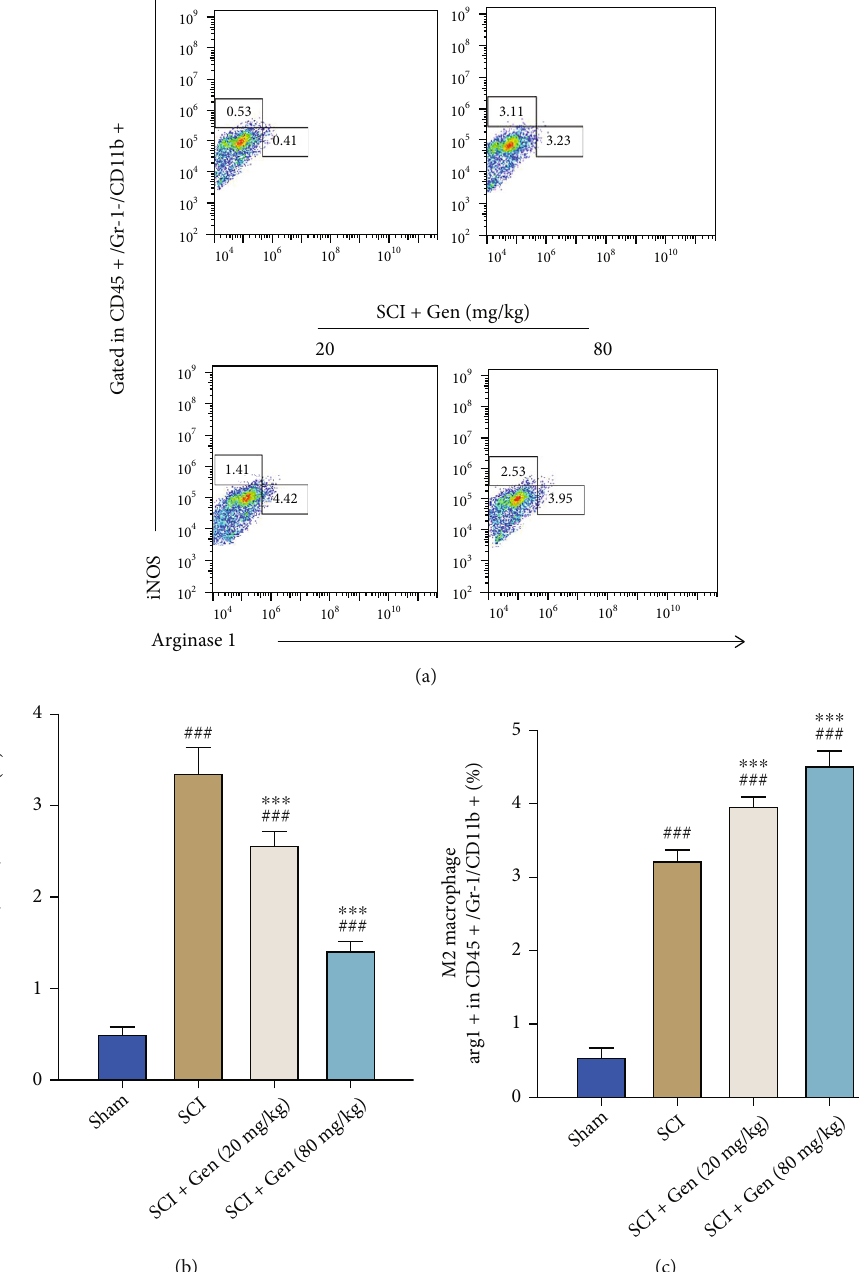
Figure 4: Genistein promoted M2 macrophage activation and inhibited M1 macrophage activation in SCI mice. (a – c) The expression of M1 macrophage marker (iNOS) and M2 macrophage marker (Arginase 1) was determined by fl ow cytometry (a) and comparison of the proportion of M1 and M2 macrophages in the SCI area of di ff erent groups of mice on 28 th day after being treated with genistein. Five mice in each group, and data were expressed as mean ± SD . P value was calculated by post hoc comparisons. ∗∗∗ P < 0 : 001 vs. SCI group. ### P < 0 : 001 vs. sham